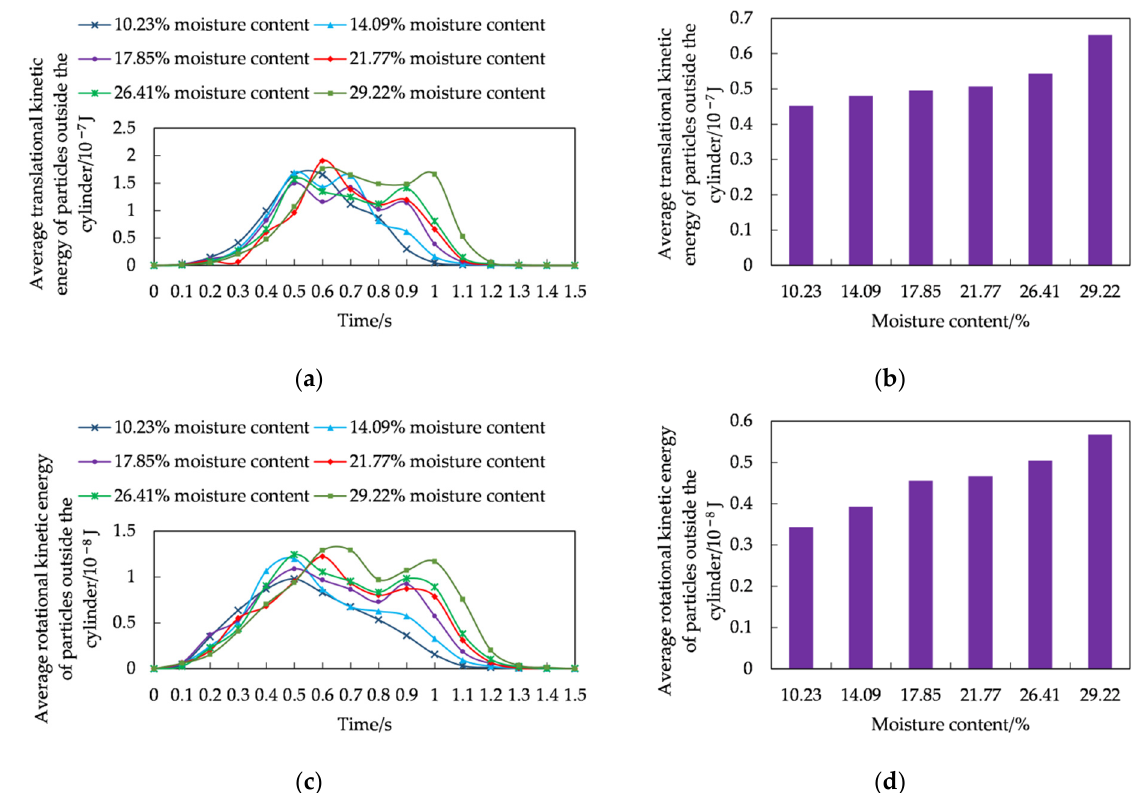
Figure 4. Average kinetic energy of rice seeds outside the cylinder: ( a ) average translational kinetic energy of rice seeds outside the cylinder at different times; ( b ) average translational kinetic energy of rice seeds outside the cylinder at the accumulation process; ( c ) average rotational kinetic energy of rice seeds outside the cylinder at different times; ( d ) average rotational kinetic energy of rice seeds outside the cylinder at the accumulation process.